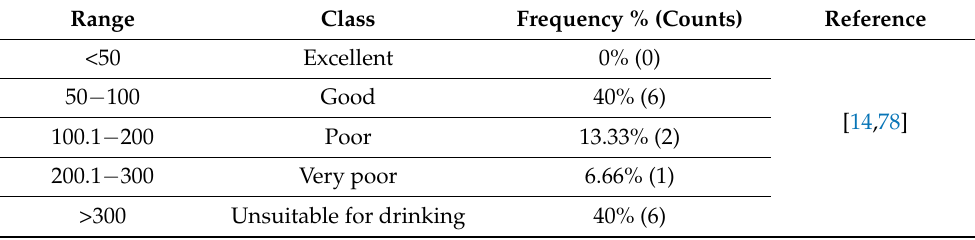
Table 3. Classification of the groundwater based on the